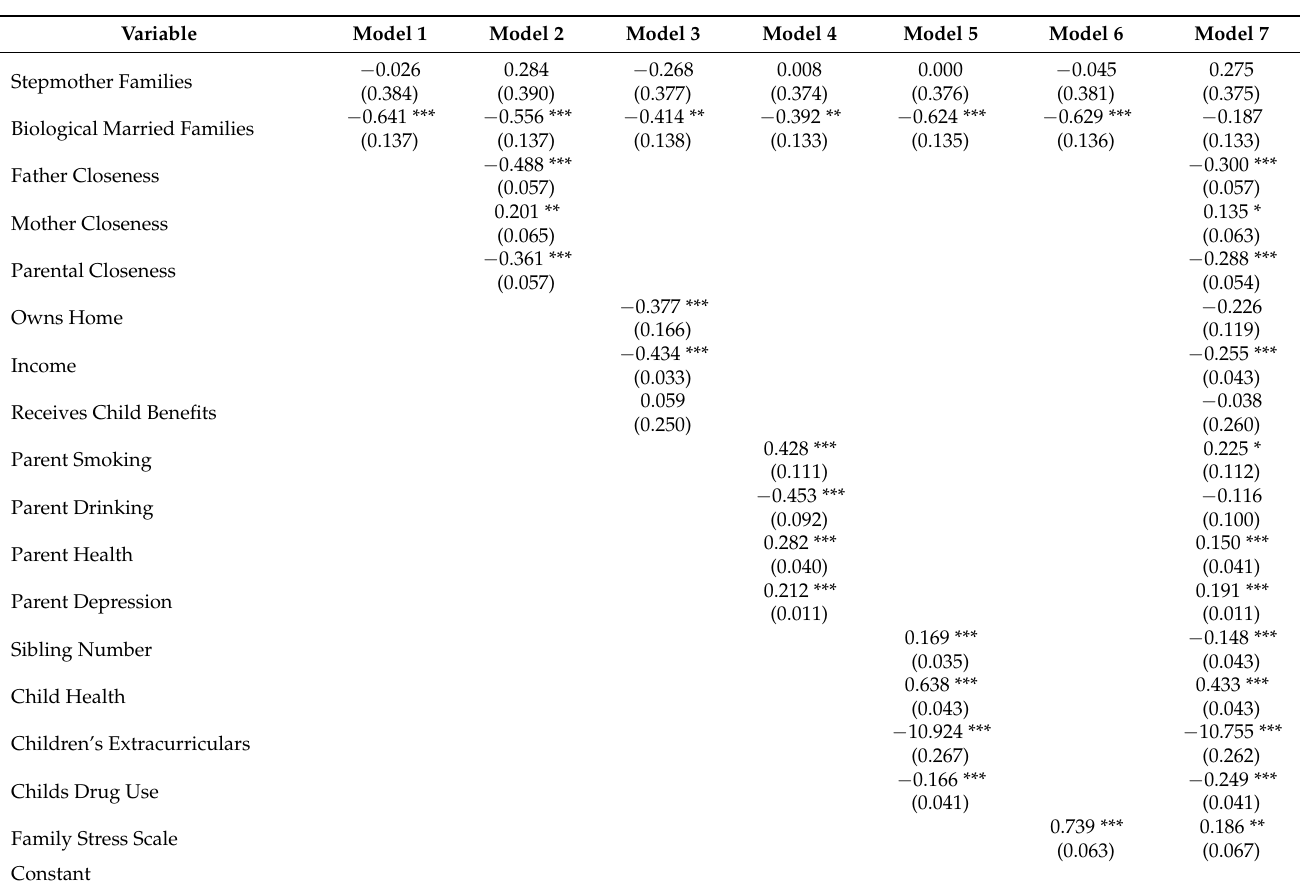
Table 5. Ordinary Least Squares Regression of Internalizing Behavior Problems on Family Structure (Model 1), Parental Closeness, (Model 2) Financial Resources (Model 3), Parental Health (Model 4), Child Health (Model 5), Family Stress (Model 6) and Full Model (Model 7). Cohabiting families with both biological parents are the reference